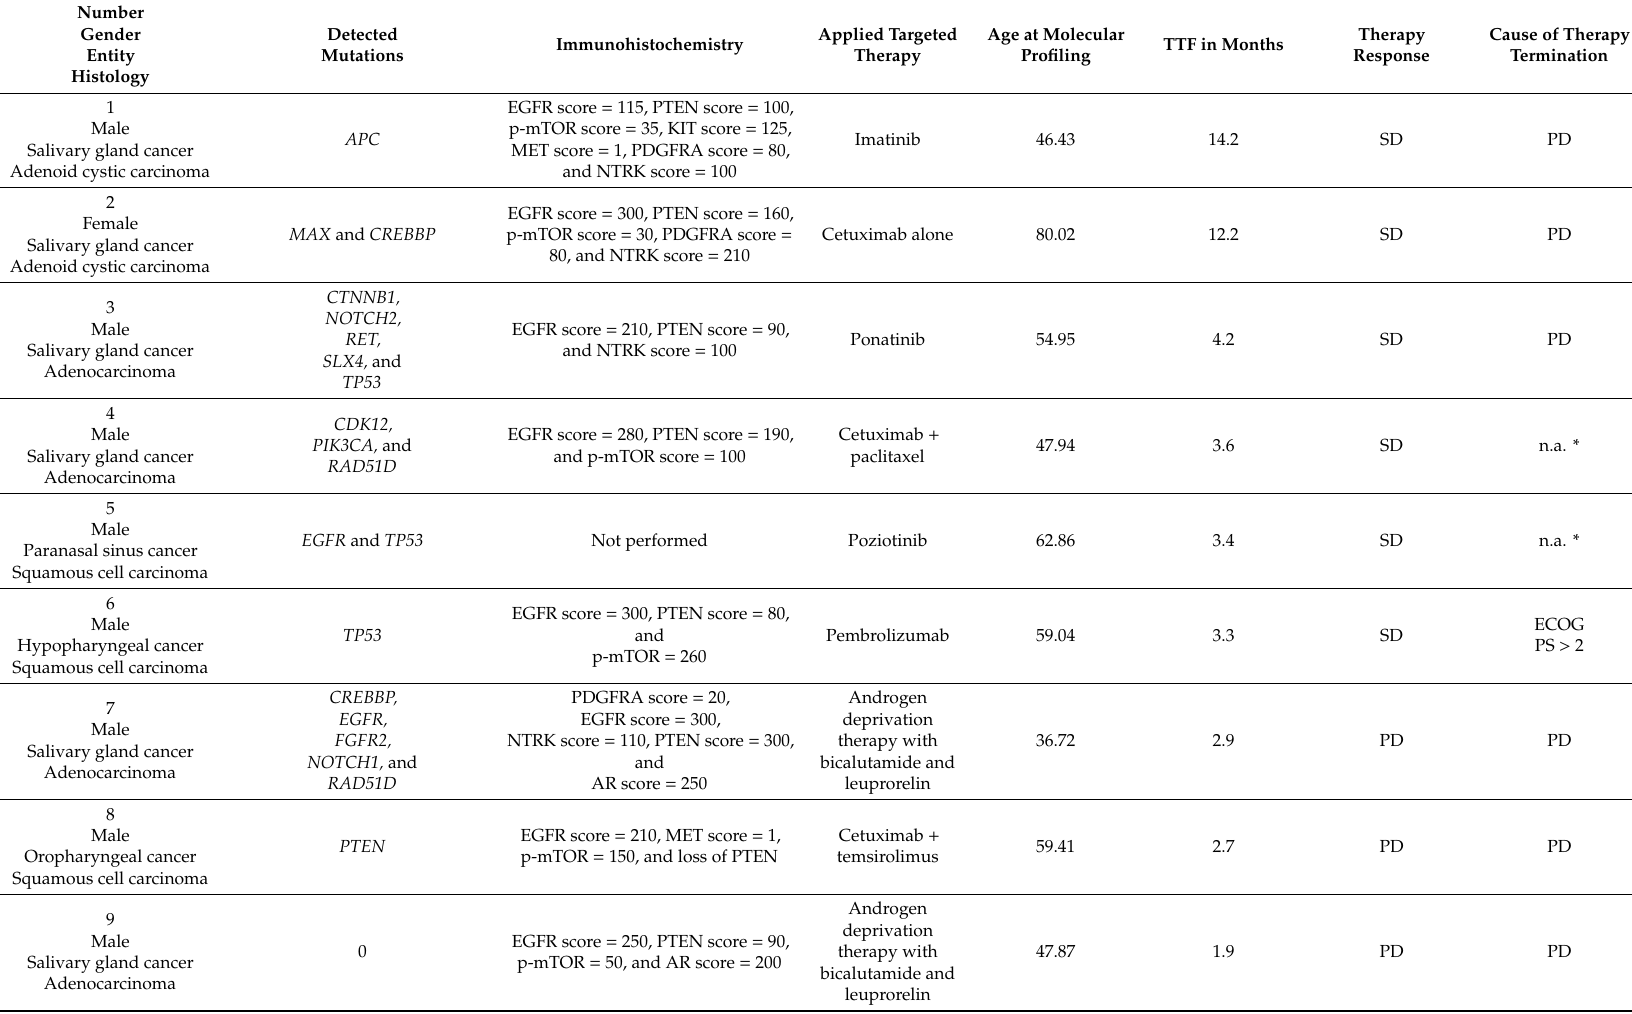
Table 5. Characteristics of the 14 R / M HNC patients receiving the molecular-based targeted therapy